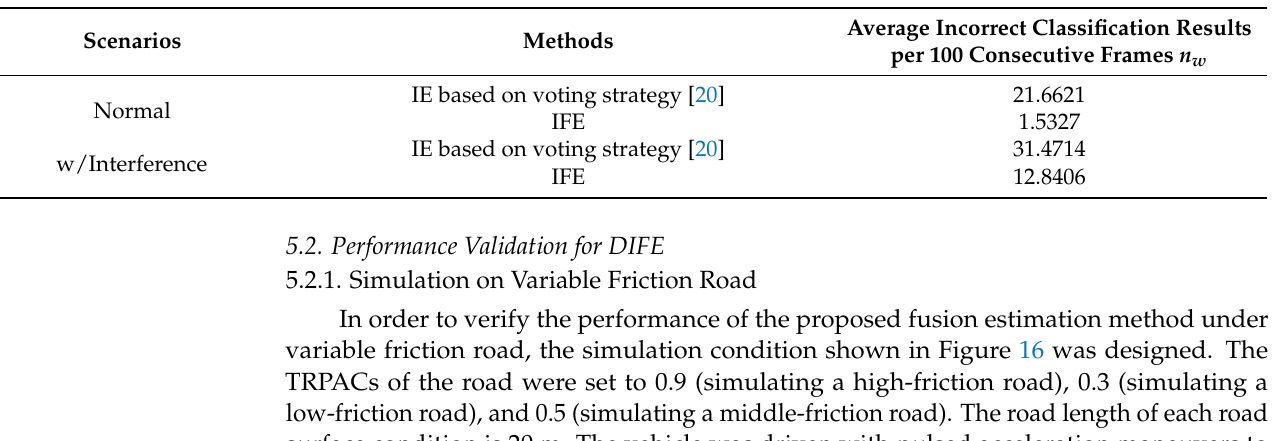
Table 4. Specific Test results of IFE.